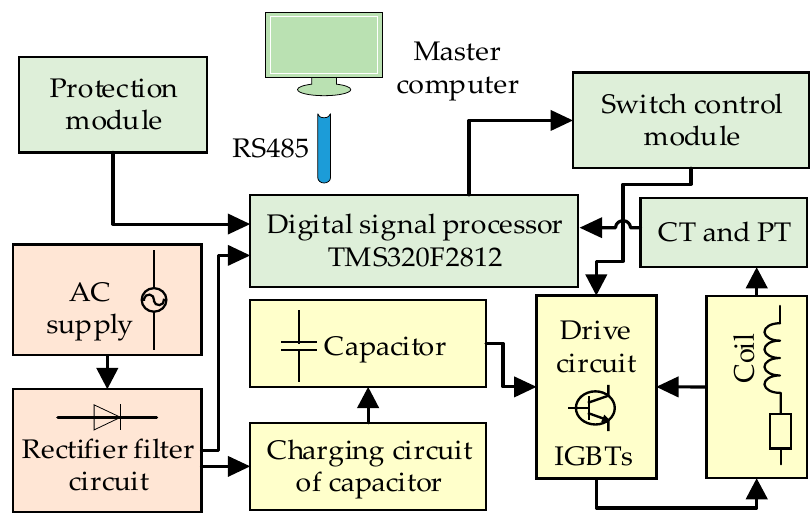
Figure 9. Hardware block diagram.